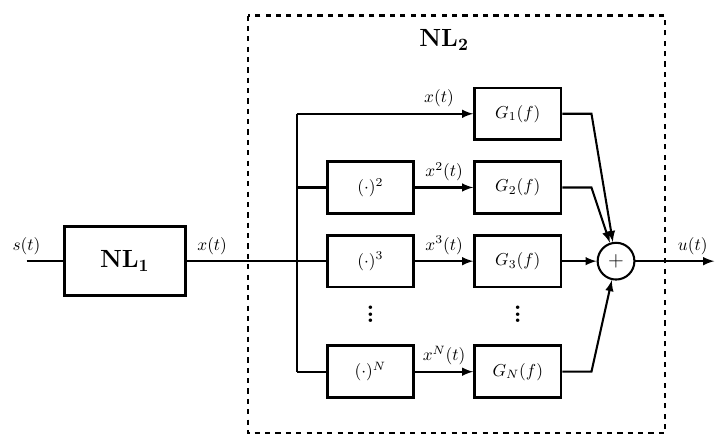
Figure A1. Two dynamic nonlinear systems in series; the first one represents the shaker, and the second one, represented by a Generalized Hammerstein model, is the pickup under